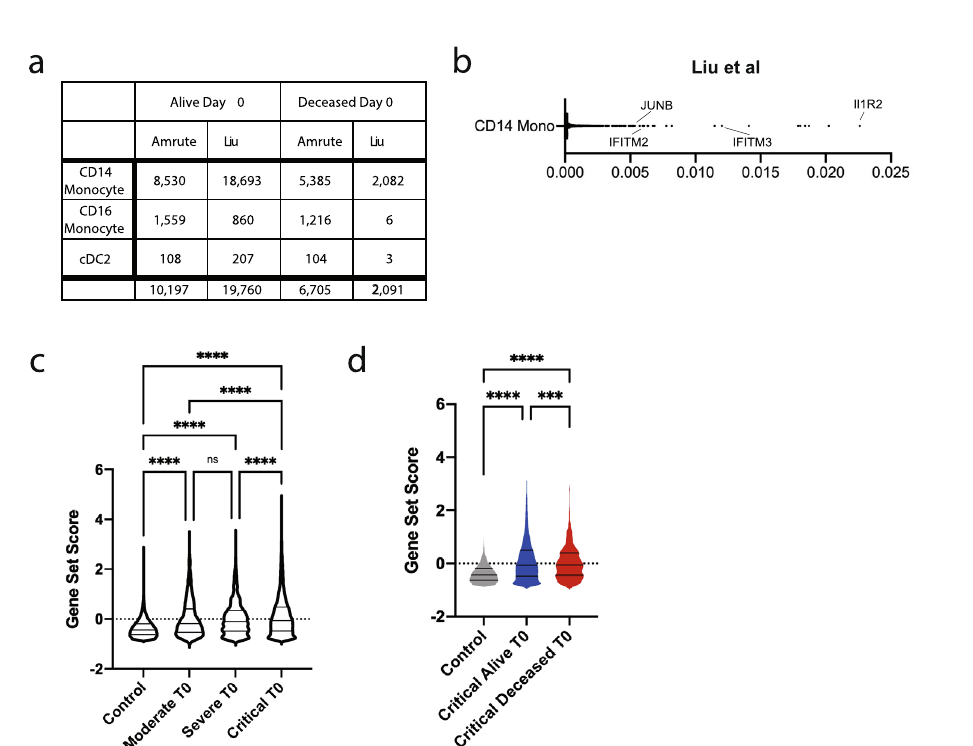
relative to controls 14,22,38,39 . We also identi fi ed later (day 7)